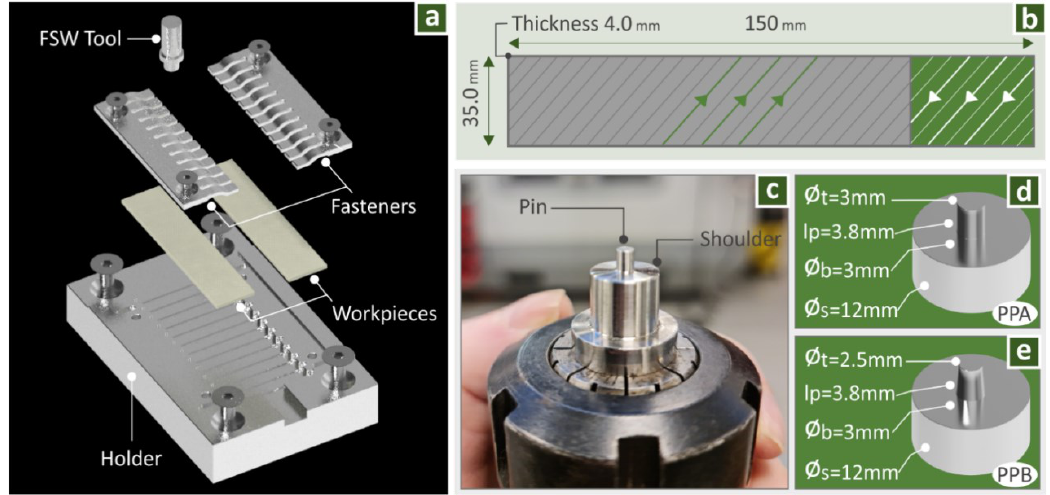
Figure 3. ( a ) Featuring the two workpieces used in each round, the welding tool, and the fixture assembly, ( b ) 3D printed workpieces dimensions and infill pattern, ( c ) welding tool, ( d ) welding tool PPA (cylindrical) dimensions, and ( e ) welding tool PPB (frustum)